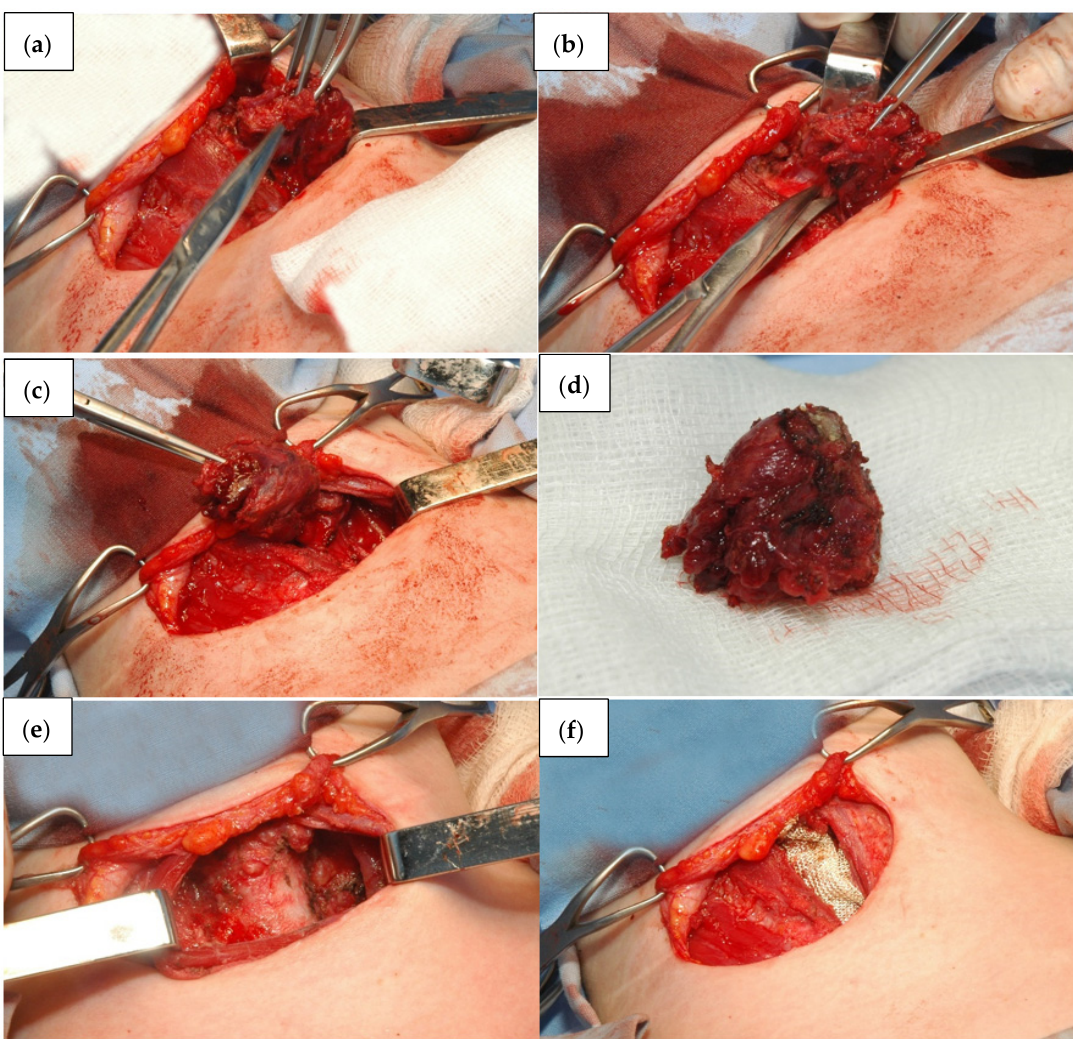
Figure 3. Steps of total thyroidectomy in pediatric patient. ( a )—left thyroid lobe is approached, ( b , c )—mobilization of the left lobe of the thyroid gland, ( d )—left thyroid lobe, ( e )—the appearance of the trachea after total thyroidectomy, ( f )—absorbable haemostat left on site for bleeding control